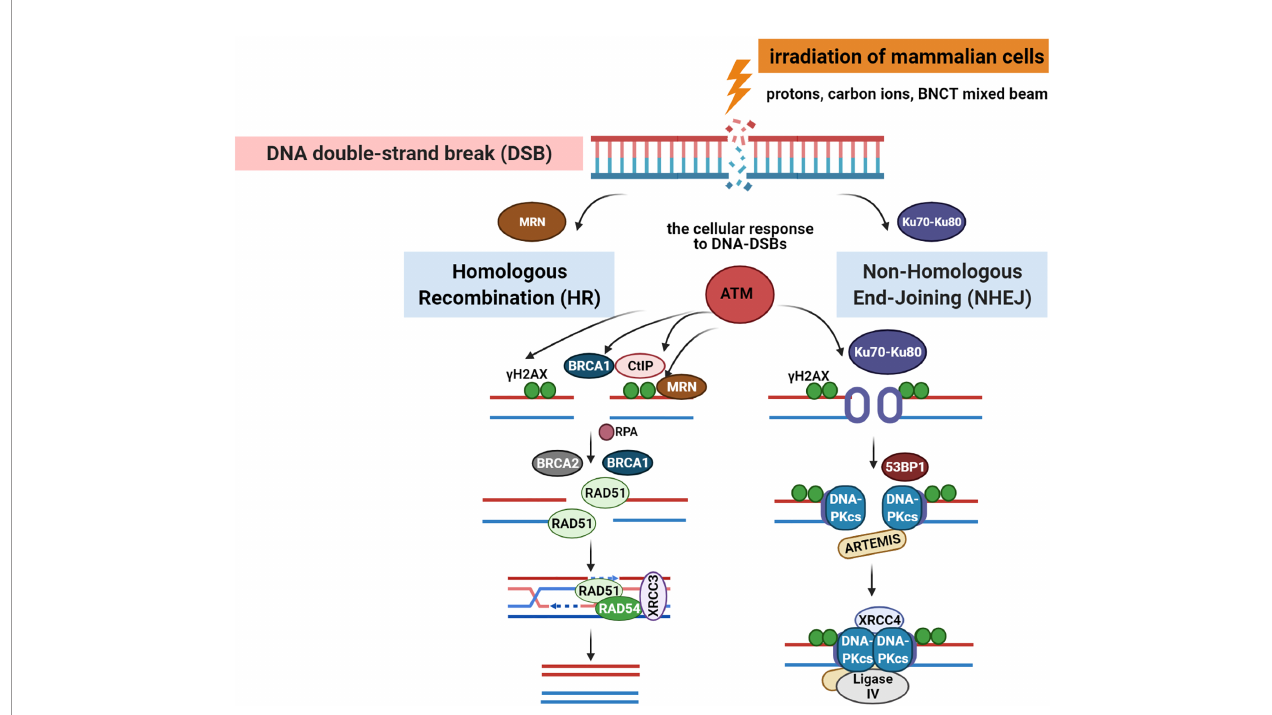
FIGURE 2 | DNA - double-stranded breaks repair pathways: homologous recombination repair (HRR) and non-homologous end-joining (NHEJ) pathway induced by low and high linear energy transfer (LET) radiation (15, 23). Created with